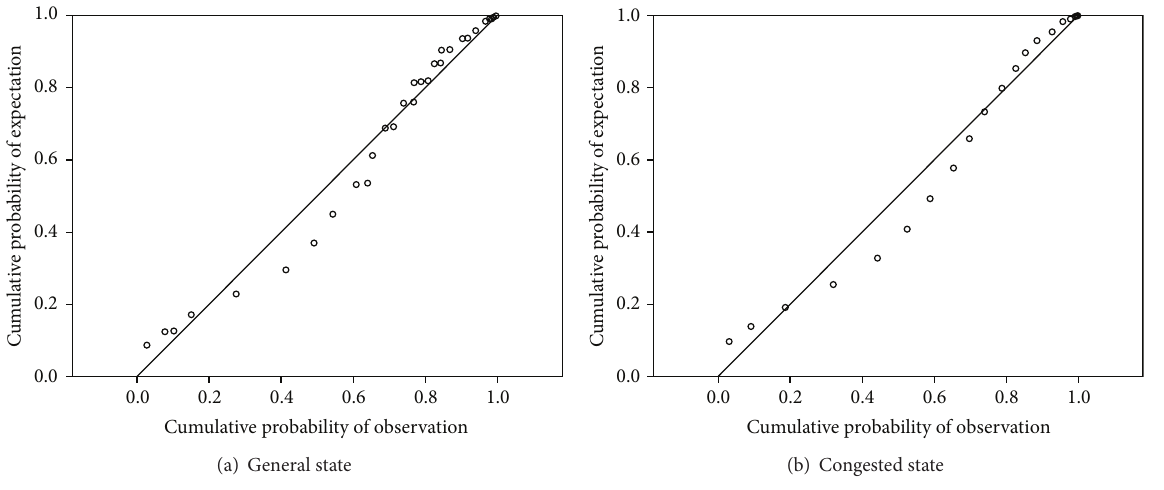
Figure 11: P-P figure of normal distribution fitting.